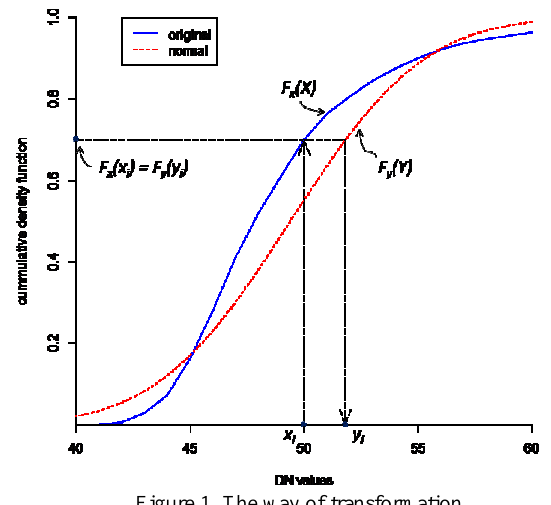
Figure 1. The way of transformation. Figure 2 indicates the distributions of training data of Red band. Five histograms in the left hand side are derived by original data and the histograms in the right hand side show distributions of the five classes after respective normalizing transformations.